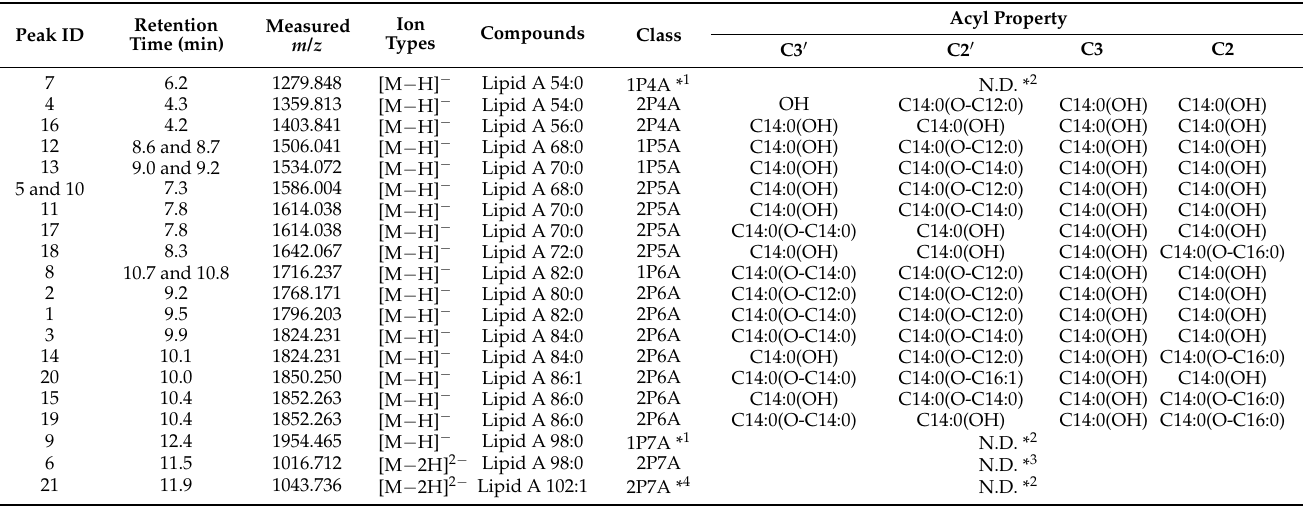
Table 1. Estimated structure moiety of E. coli lipid